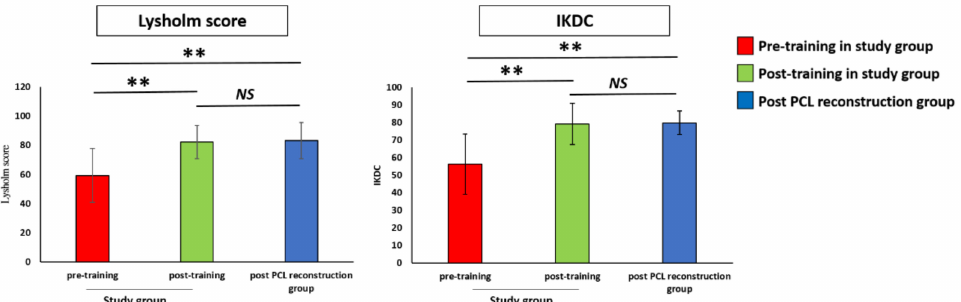
Figure 4. Comparison of Lysholm and IKDC scores at pre-training, at post-training, and in the post-PCL reconstruction group. IKDC: International Knee Documentation Committee. PCL: Posterior cruciate ligament. ** p < 0.01 indicates high statistical significance between two groups. NS: No significant difference between two